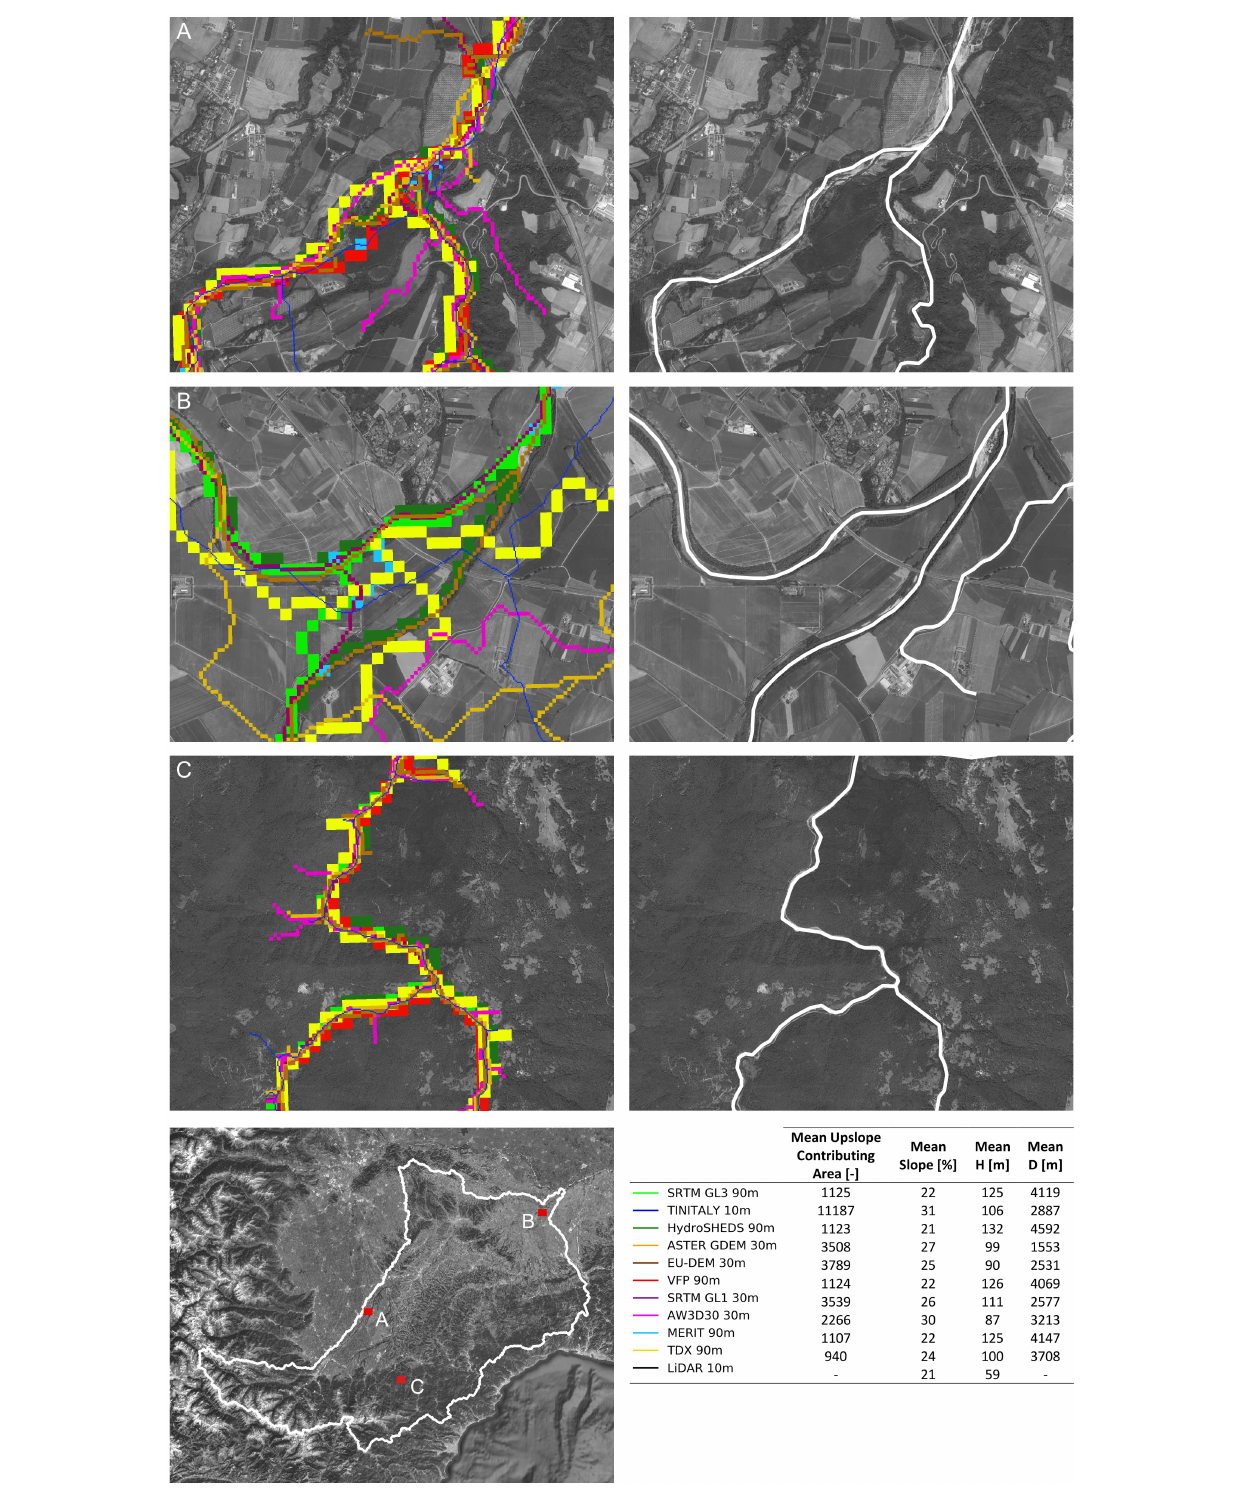
FIGURE 5 | Overlay of river networks for three distinct regions in the Tanaro river basin, Italy, derived from free digital elevation models (DEM). For each region, the corresponding EU-Hydro photo-interpreted river network is shown on the right. (A,B) are sample regions representative of flatter terrain; and (C) is a sample region representative of mountainous terrain. On the bottom left, the locations of the three regions within the Tanaro river basin are marked with red boxes. On the bottom right, the average values of the terrain descriptors are presented.